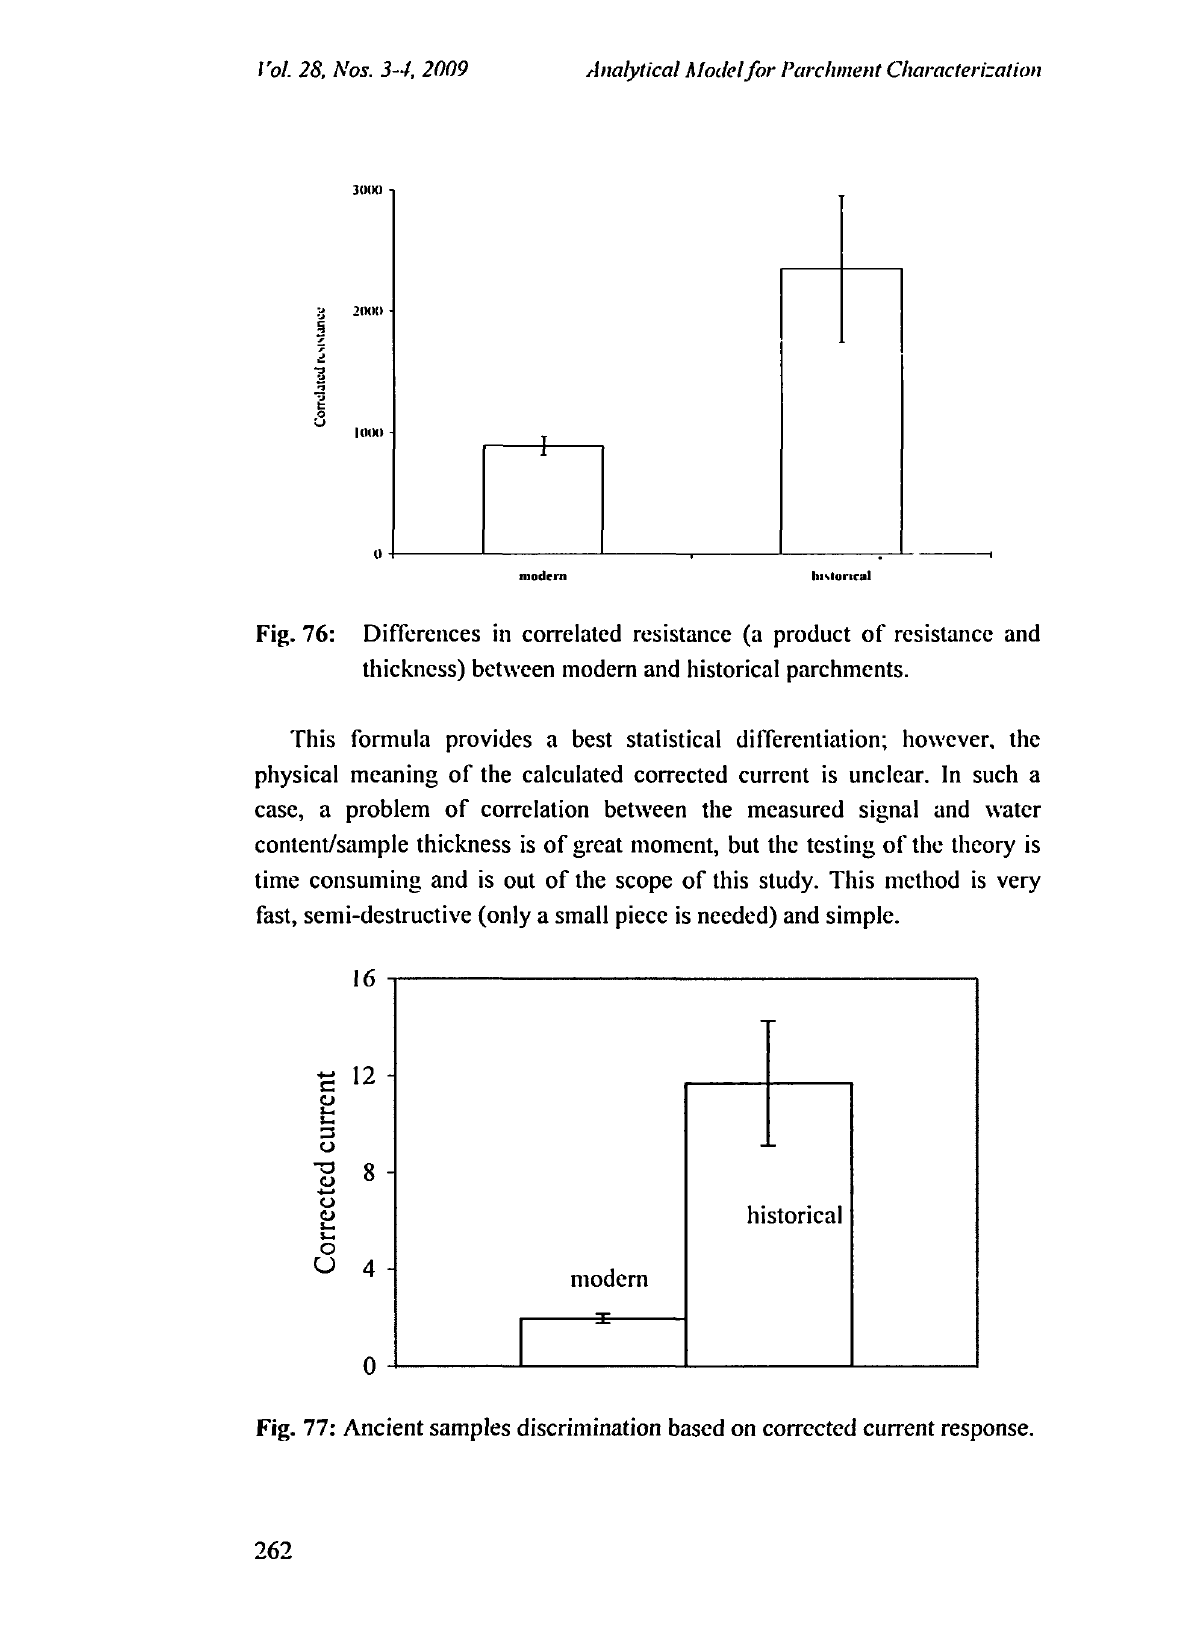
Fig. 77: Ancient samples discrimination based on corrected current response.